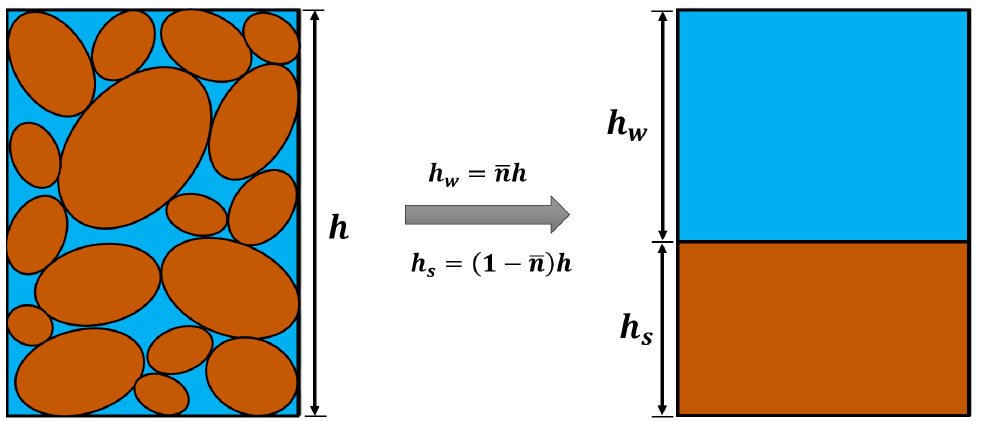
Figure 1. Scheme for obtaining partial heights of both